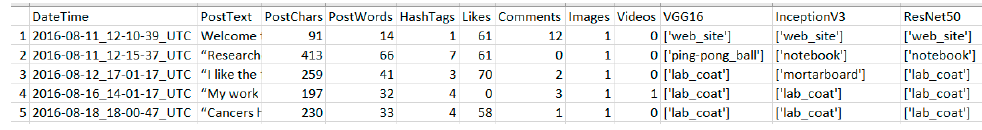
Figure 1. pfizer account posts metadata.